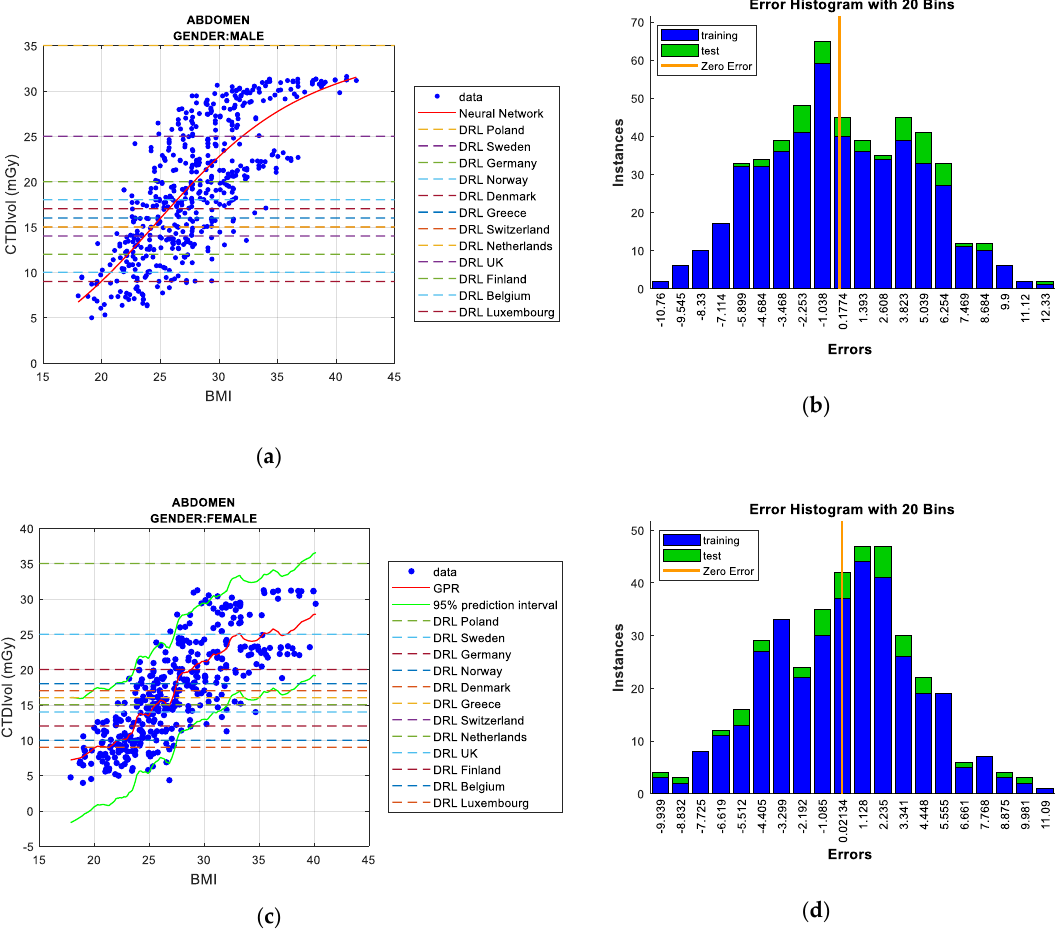
Figure 9. CTDI VOL prediction according to BMI including European DRLs for men’s / women’s abdomen protocol ( left ), together with error histograms ( right ), employing the Neural Networks ( a , b ) for men and the GPR ( c , d ) for women.